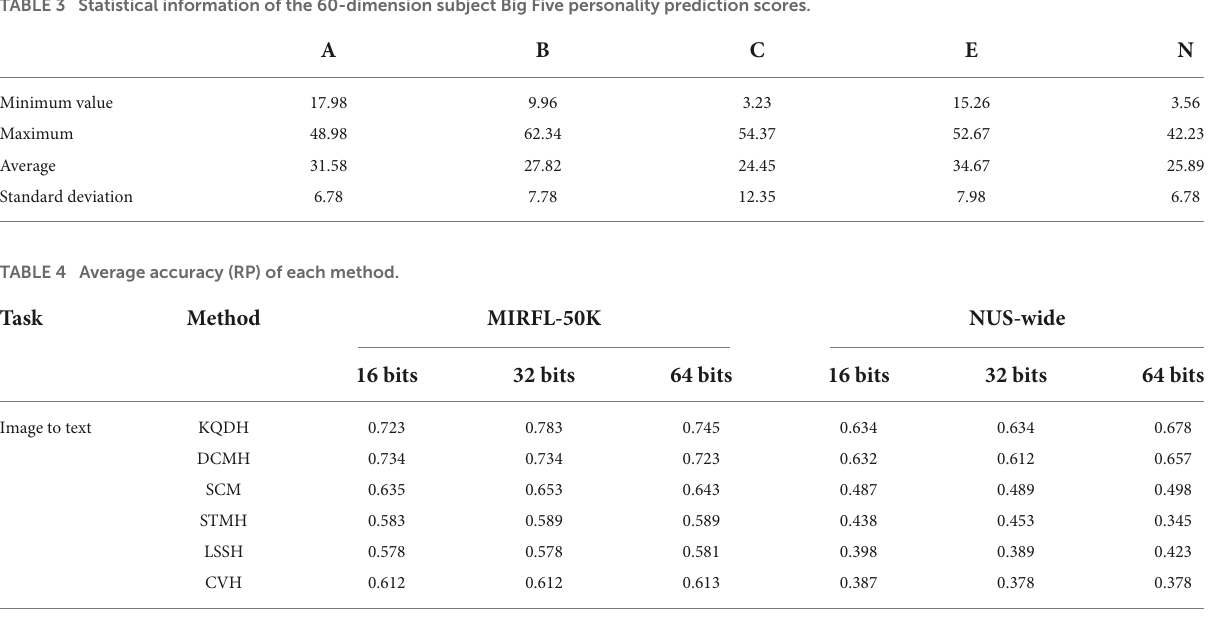
TABLE 3 Statistical information of the 60-dimension subject Big Five personality prediction scores.